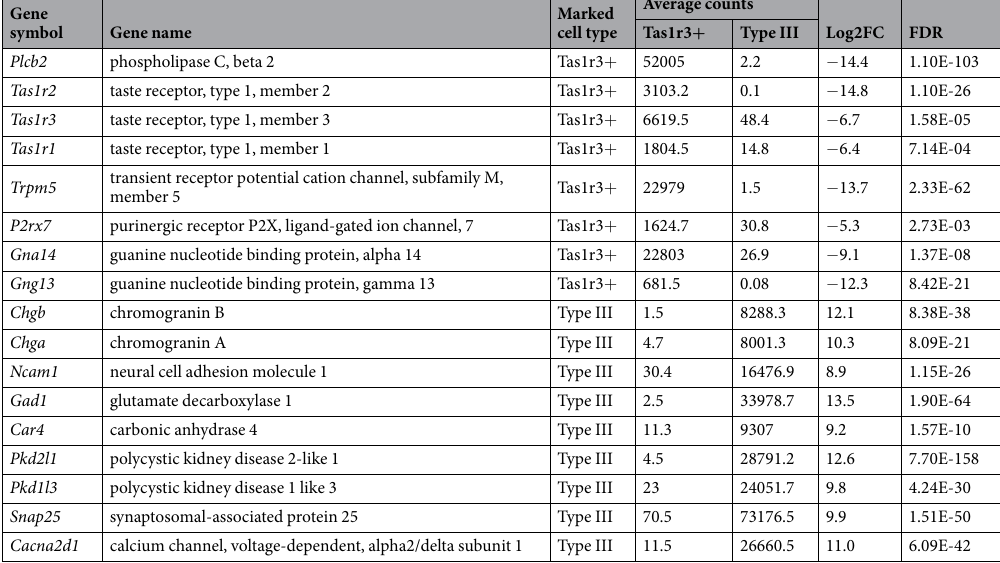
terms associated with signal transduction through membrane-associated receptors (GO terms response to stim- ulus, intracellular signal transduction, and membrane rafts). This corresponds to the known involvement of these cells in transduction of sweet and umami taste. Also, GO terms related to the innate immune response and inflammatory response were up-regulated in these cells, consistent with recent findings that these cells produce cytokines and other immune regulators and are affected by infection and autoimmunity 47–50 .